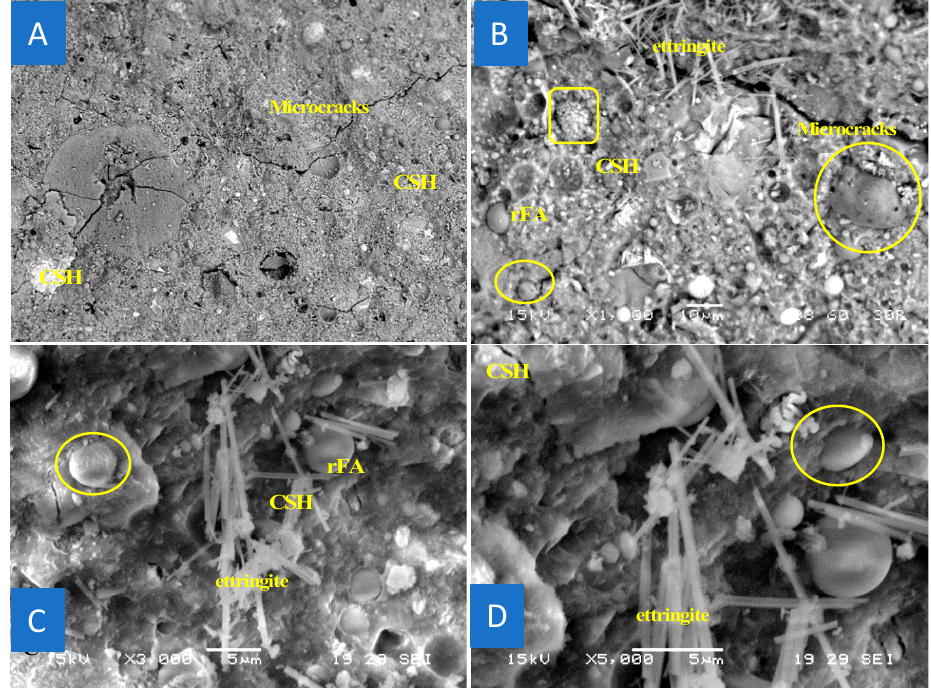
Figure 24. BSC micrograph of PC50LS20FA20+10% μ S at 28D at ( A ) 200× magnification, ( B ) 1000× magnification, ( C ) 3000× magnification and ( D ) 5000× magnification.